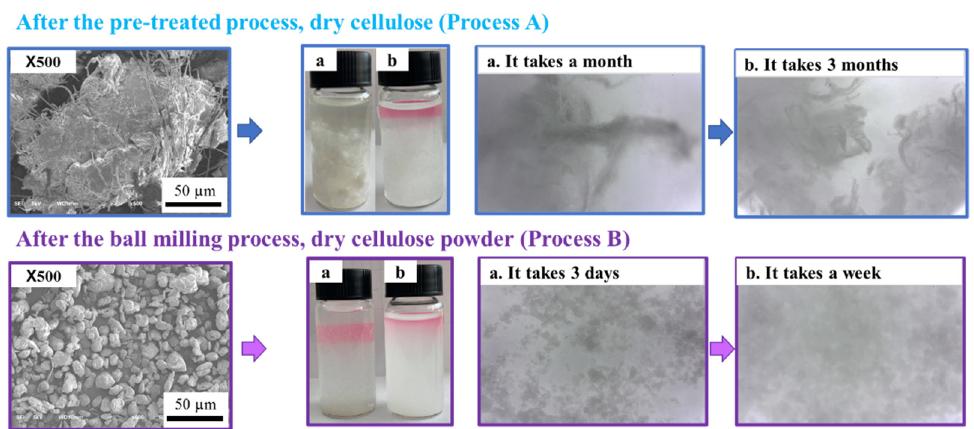
Figure 12. Comparison of cellulose powder and after pretreating the cellulose to form a suspension.